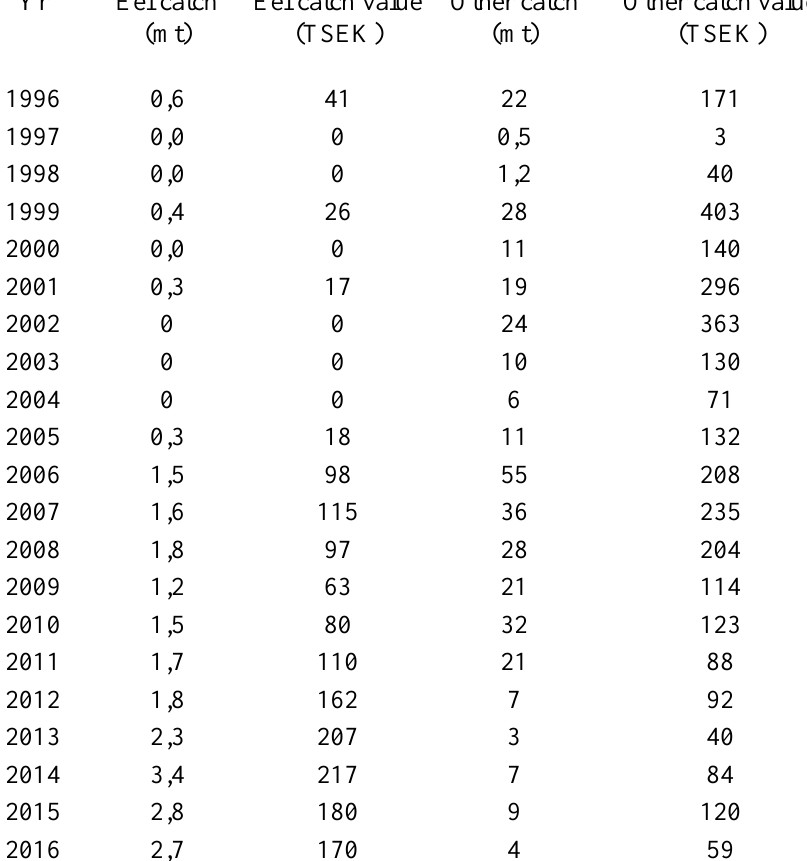
Table A1.3. Raw data of catch and catch value that pound net fishers landed with other gear types than pound nets. Catch is presented in metric ton (mt) and catch value is presented in thousand Swedish krona